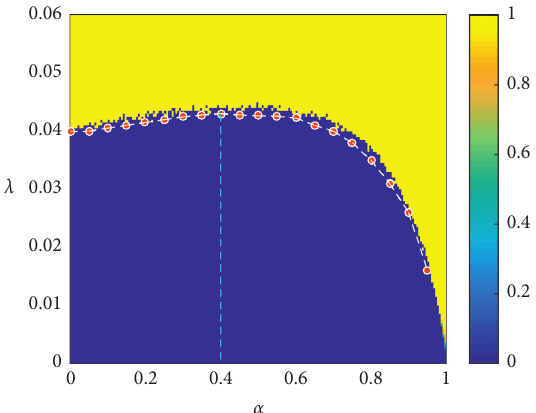
Figure 7: The phase diagram in the parameter plane ( α − λ ) on RRNs. Colors encode the value of ρ obtained from Monte Carlo simulations. Red circles connected by dotted lines represent the- oretical predictions of epidemic threshold λ c . The blue dotted line . Data are obtained by indicates the location of optimal value α opt averaging 50 Monte Carlo simulations for each point in the grid 200 ×